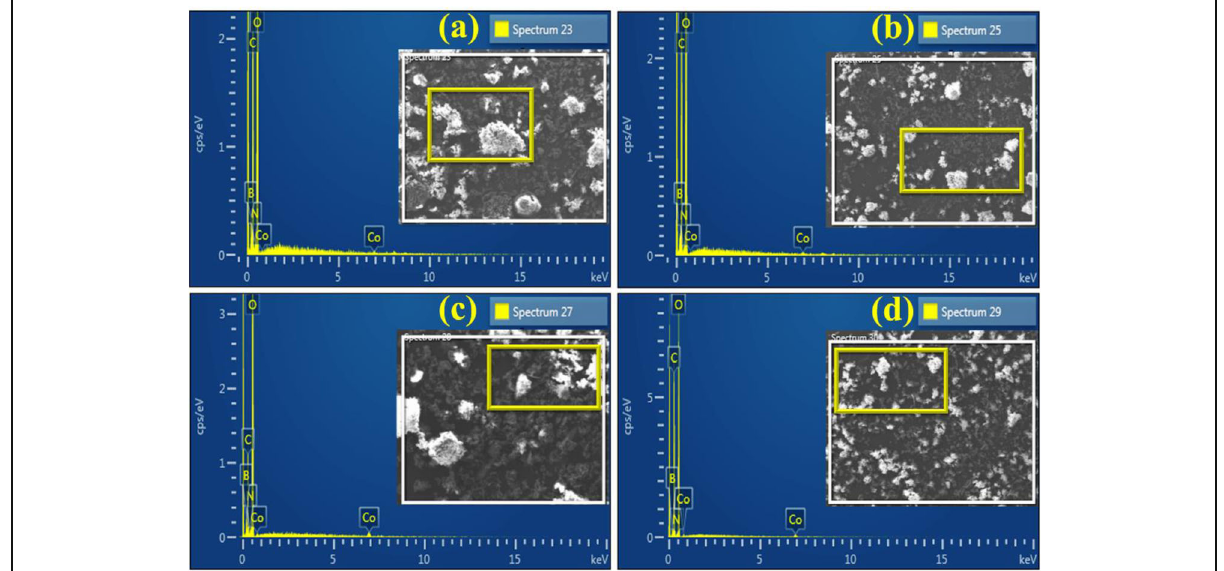
Fig. 8 a – d EDS analysis of various concentrations (2.5, 5, 7.5, and 10 wt%) of Co-doped